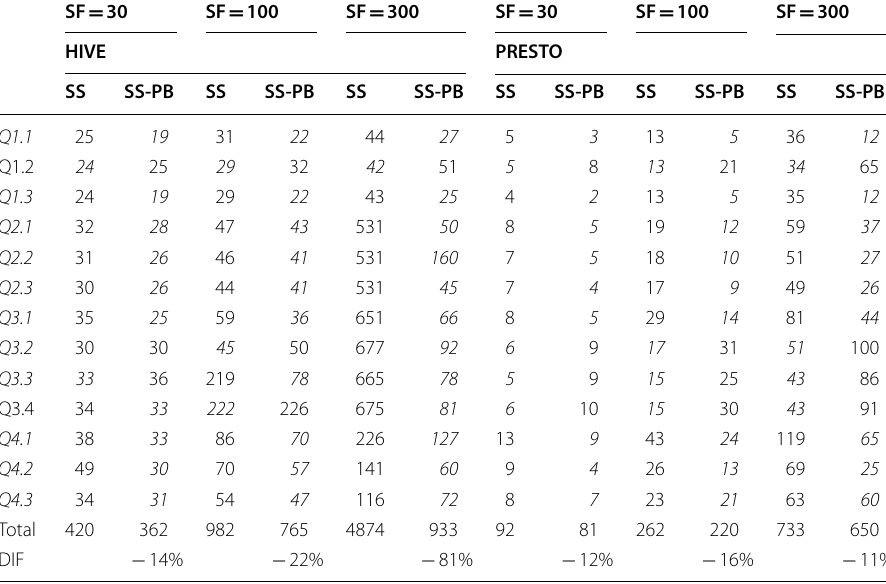
Table 11 SSB execution times (in seconds): partitioning by “Od_Year” and “S_Region” and bucketing by